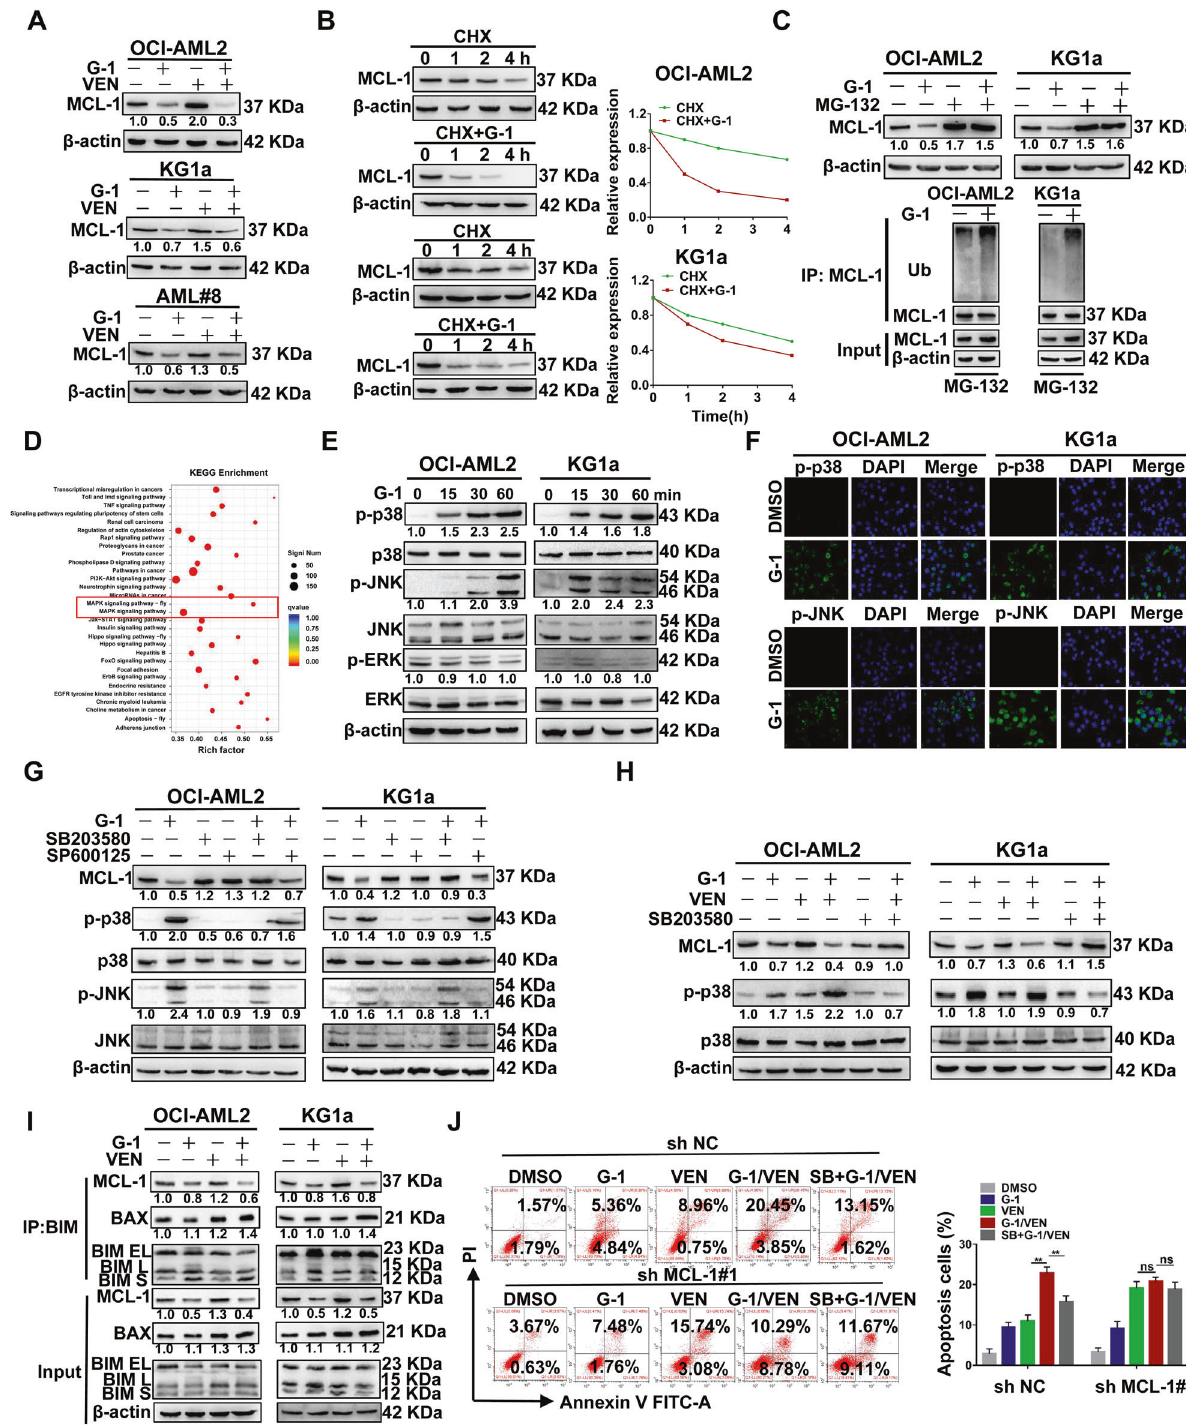
Fig. 5 The combination treatment induces apoptosis by downregulating MCL-1 via p38-MAPK signaling. A Western blotting of MCL-1 in the same treated cells as in Fig. 3D – F. B Western blot analysis of MCL-1 in the cell lines pretreated with CHX (10 μ g/ml) for 1 h and then treated with 1 μ M G-1 at indicated time points. C Western blotting of MCL-1 in the cell lines treated with 1 μ M G-1 for 24 h, with or without pretreatment with MG-132(1 μ M) for 1 h. Ubiquitination analysis of the ubiquitinated MCL-1 level. D KEGG analysis of these signi fi cant gene signatures from corresponding NES. E Western blot analysis of MAPK downstream signaling in the cell lines treated with 1 μ M G-1 for the corresponding times. F IF staining of the p-p38 and p-JNK (green). The nucleus was stained blue with DAPI (scale bar, 50 μ m). G Western blot analysis of MCL-1 in the cell lines pretreated with 1 μ M SB203580 (SB) or 5 μ M SP600125 (SP) for 1 h and then exposed to 1 μ M G-1 for 24 h. H Western blot analysis of MCL-1 in the cell lines pretreated with 1 μ M SB for 1 h, followed with G-1 and VEN, alone or in combination for 24 h. I IP analysis followed by western blot of BIM binding proteins in the cells treated with G-1 and VEN, alone or in combination for 24 h. J FCM of apoptosis in the cells infected with sh RNA targeting MCL-1 pretreated with 1 μ M SB for 1 h, and then exposed to G-1 and VEN, alone or in combination for 24 h. The data are expressed as the mean ± SD ( n = 3). ** p < 0.01. ns, not signi fi